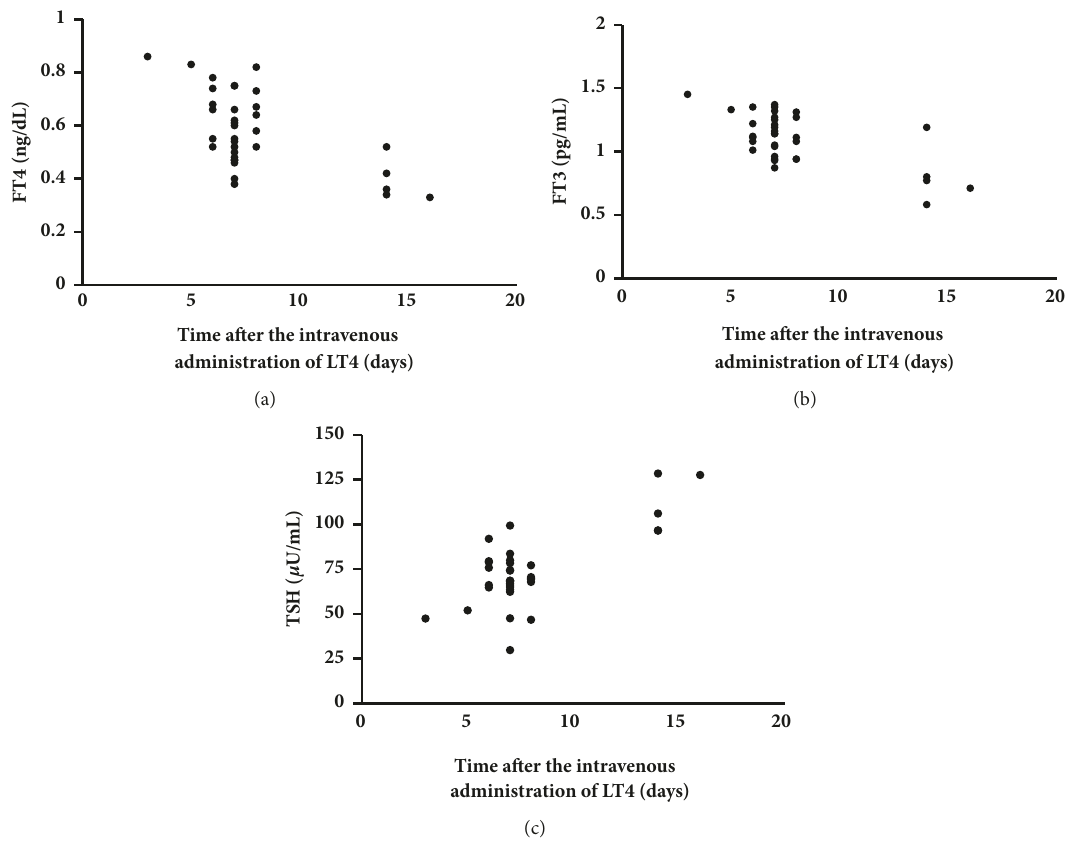
Figure 2: Serum thyroid hormone and TSH levels after the intravenous administration of a single bolus of LT4 (300 𝜇 g) . Serum FT4 (a), FT3 (b), and TSH (c) levels were measured several times of the administration.